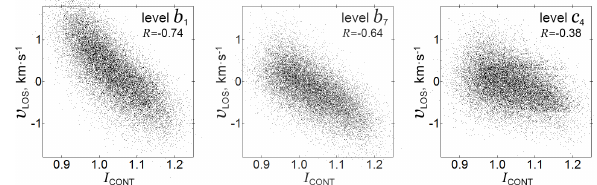
Figure 3. The scatterplots for the LOS velocity against the contin-